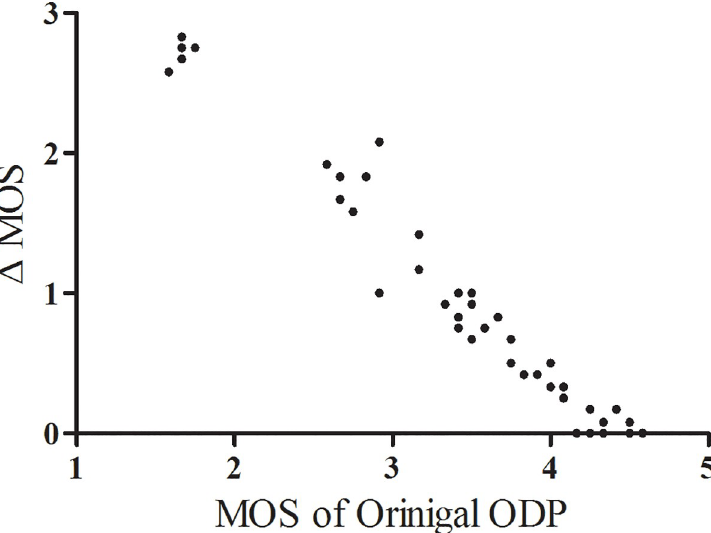
Fig 7. Scatter plot of delta mean opinion score ( Δ MOS) against MOS of original optic-disc photography (ODP). The Δ MOS was calculated as the difference between the original and enhanced ODP scores. Note that the lower the original ODP image quality score, the larger the Δ